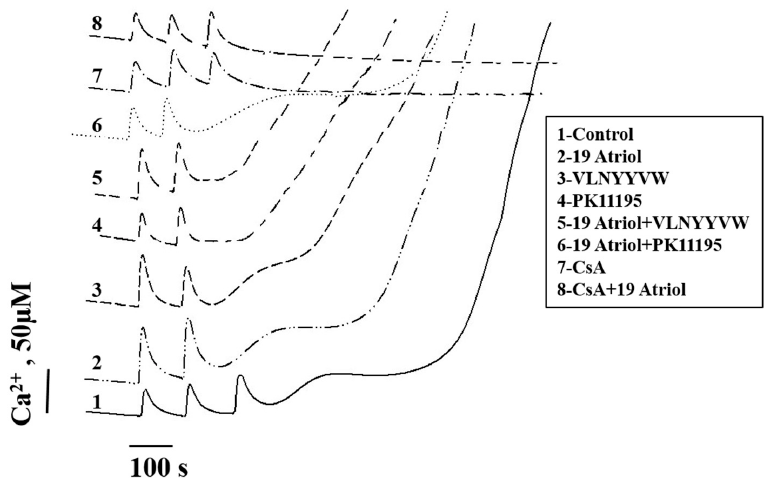
Figure 3. Effect of 19 ‐ Atriol, VLNYYVW, and PK 11195, as well as 19 ‐ Atriol in combination with VLNYYVW and PK 11195, on Ca 2+ accumulation and Ca 2+ release in RLM. Traces 7 and 8 indicate Ca